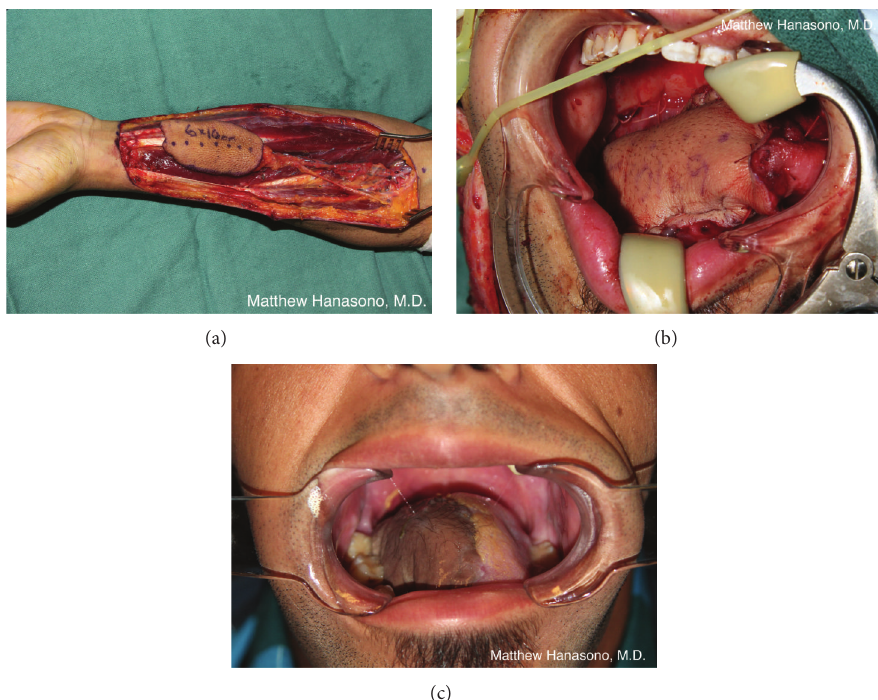
Figure 9: Radial forearm free flap harvest for a right hemiglossectomy reconstruction (a). Flap inset (b). Postoperative appearance